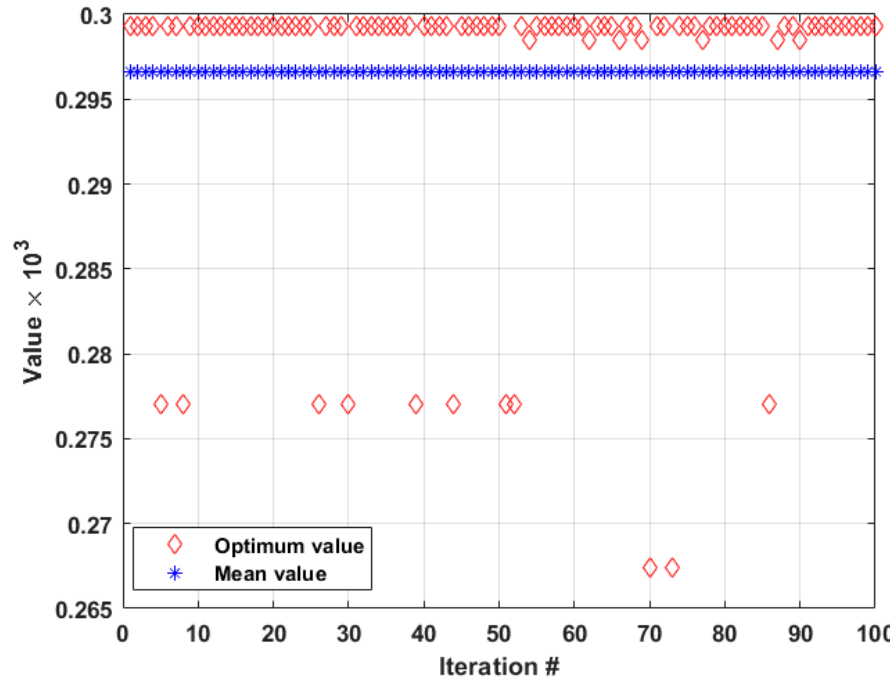
Figure 6. Evaluation of PSO optimization using 100 runs.